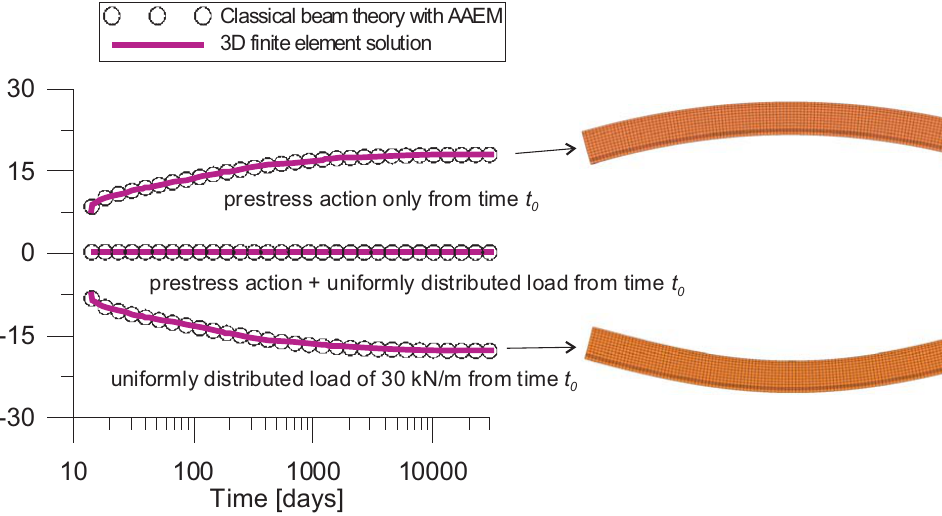
Figure 5. Mid-span deflection of the beam in Figure 5 in logarithmic scale for different loading conditions obtained by 3D finite element analysis (with the amplified deformation) and by the beam theory with the effective modulus